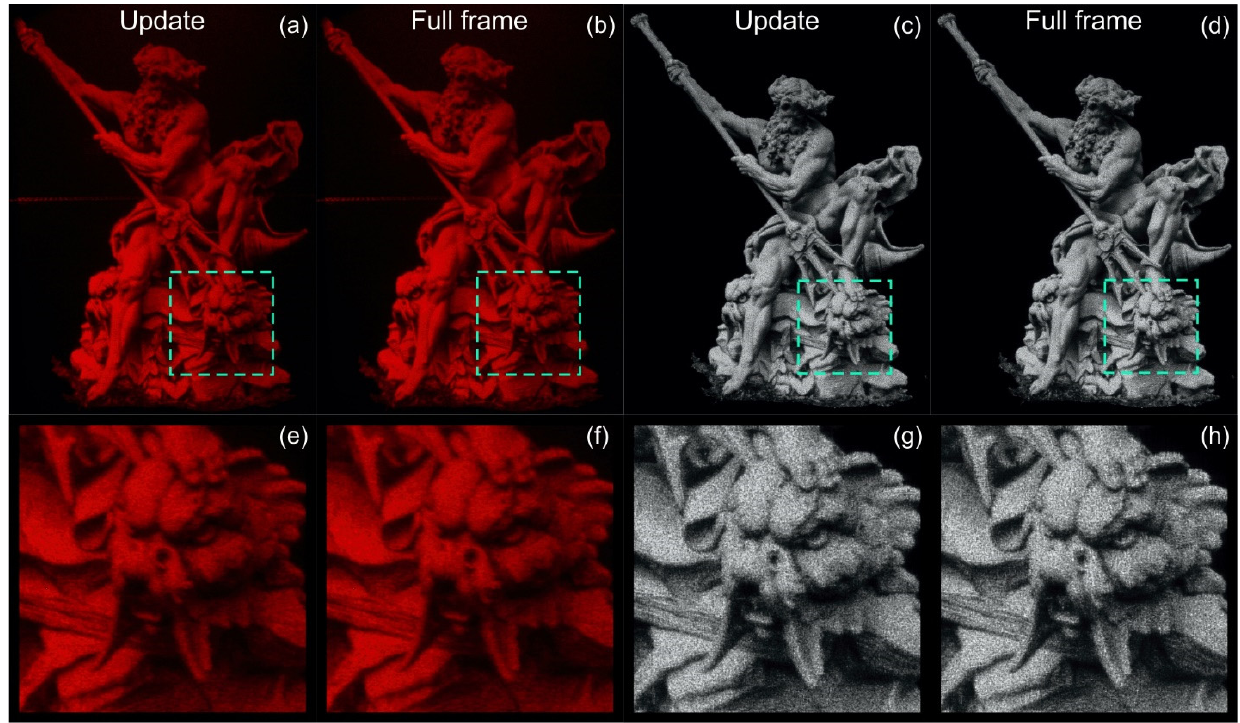
Figure 10. The optical ( a , b ) and numerical ( c , d ) reconstruction of CGHs of Neptune statue, observed from the angle 340°; ( e – h ) zooms of the sea dragon face.